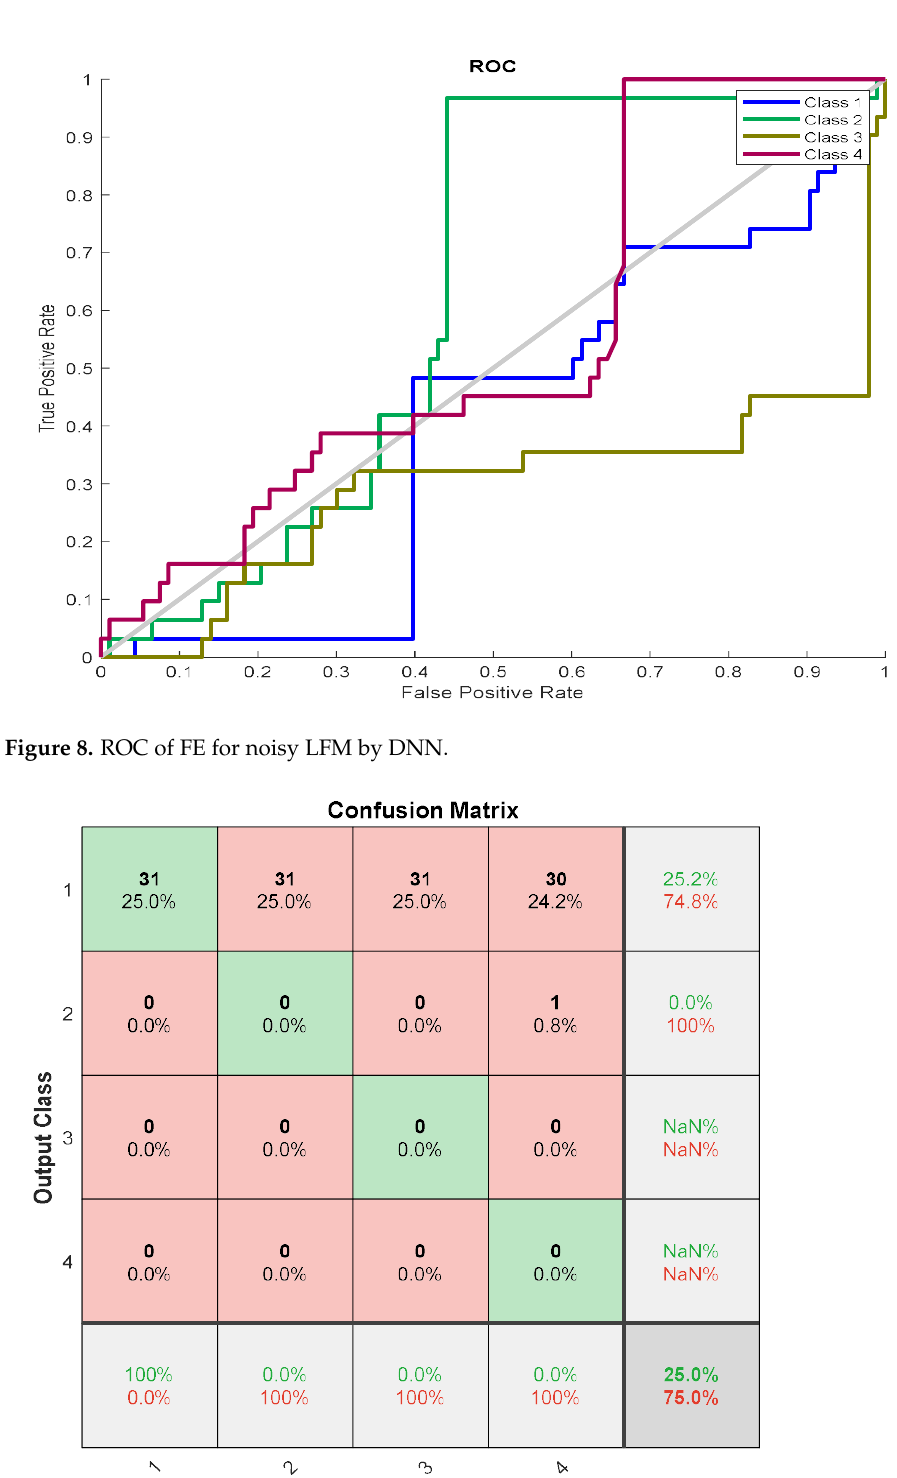
Figure 7. GSNR vs. RMSE of FE for noisy LFM by DNN.